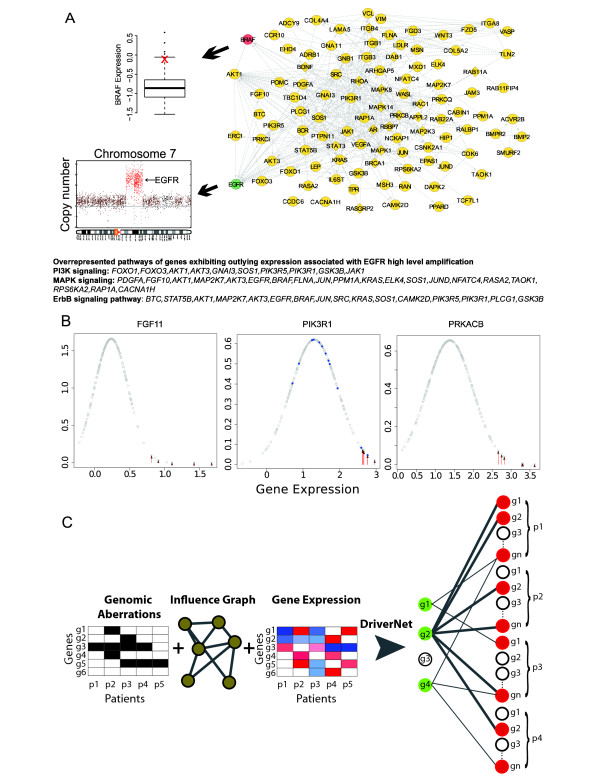
A schematic showing how DriverNet works. (a) An example of a Cytoscape visualization of a glioblastoma patient with a high-level amplification of epidermal growth factor receptor (EGFR) (shown in green) and coincident outlying expression of genes connected to EGFR in the Reactome influence graph (shown in yellow). Examples of the overrepresented pathways (by Reactome FI plug-in for Cytoscape, FDR < 0.001) from the list of genes showing outlying expression associated with the EGFR amplification are depicted at the bottom. The box plot shows the population-level expression distribution of BRAF, an interacting protein with EGFR, and where the specific case with EGFR amplification sits on that distribution (red 'x'). We note that in this case, BRAF itself is not mutated or amplified. (b) Fitted Gaussian expression distributions of three genes that interact with EGFR: FGF11, PIK3R1, and PRKACB, with each point indicating the probability density function for individual cases. For each gene, blue dots indicate cases with mutations in the gene itself and red arrows indicate cases with outlying expression with coincident EGFR amplifications. (c) Schematic representation of the DriverNet approach. Given the genomic aberration states for different patients and genes, gene expression data, and the influence graph, which captures biological pathway information, the bipartite graph shown on the right is constructed. Green nodes on the left partition of the bipartite graph correspond to aberrated genes and nodes on the right represent the outlying expression status for each patient where red indicates outlying patient-gene events from the gene expression matrix. The genes with the highest number of outlying expression events (for example, g2) are nominated as putative drivers.